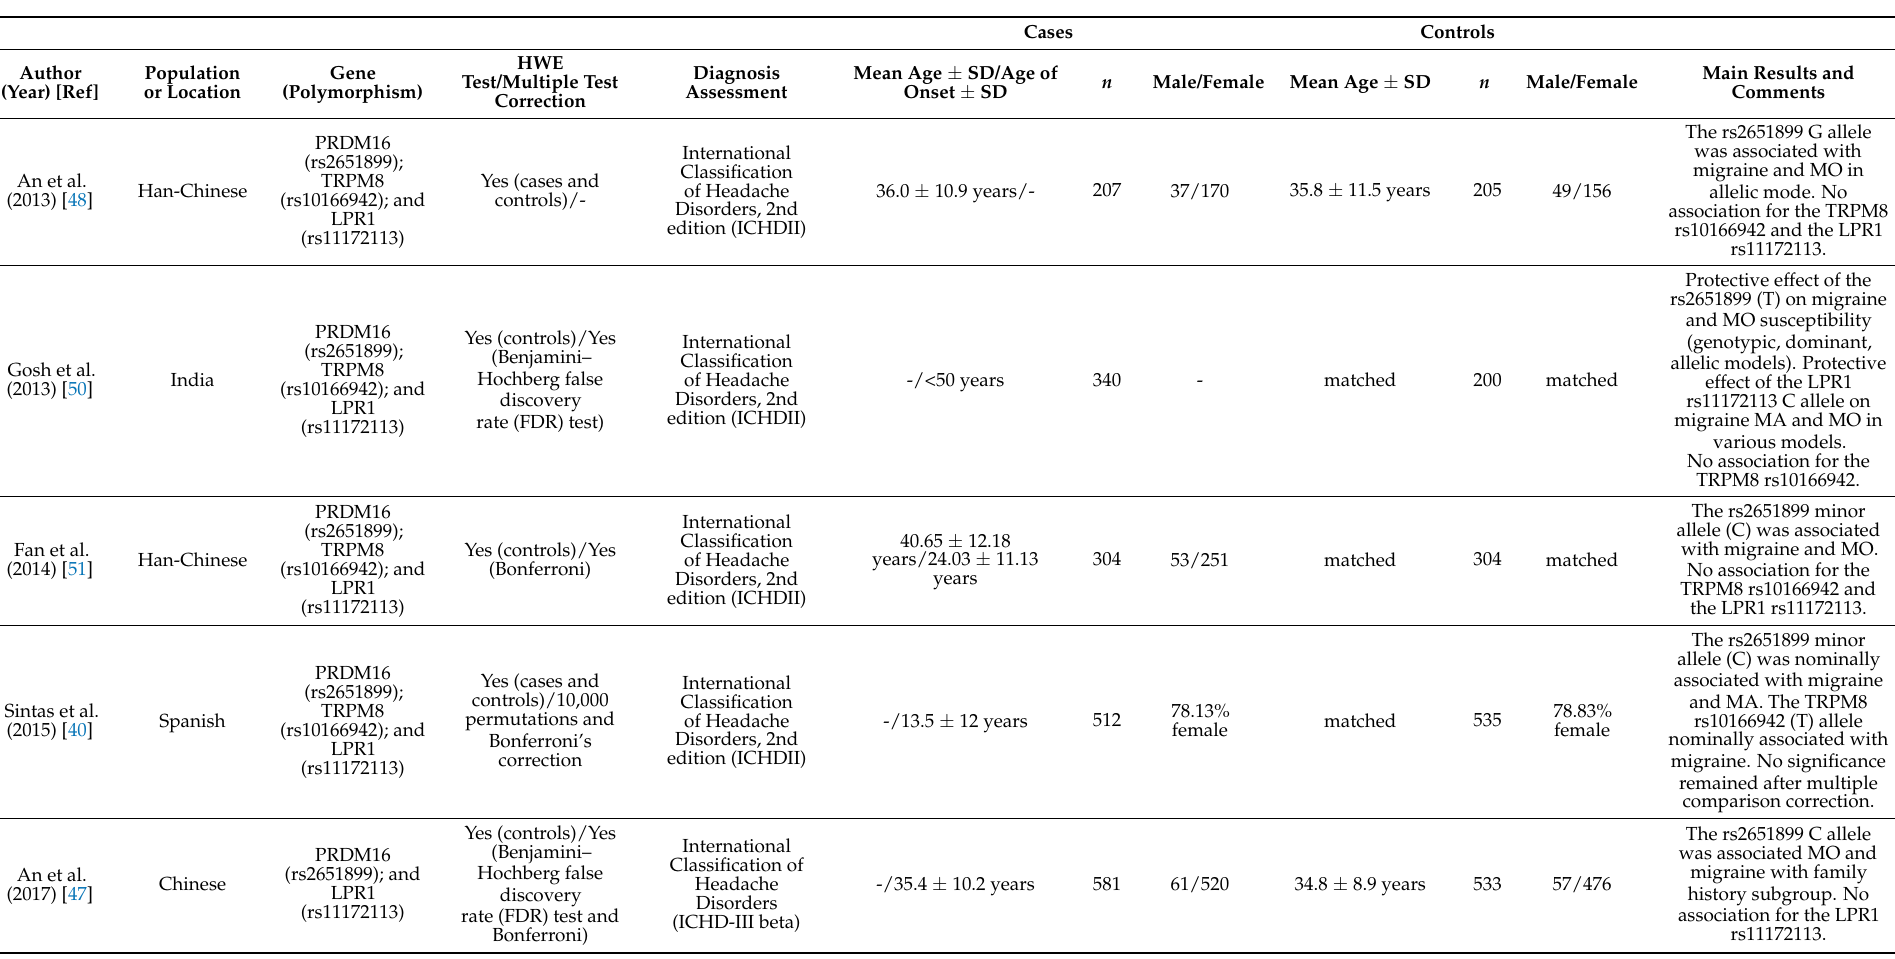
Table 1. The baseline characteristics of the studies included in the current